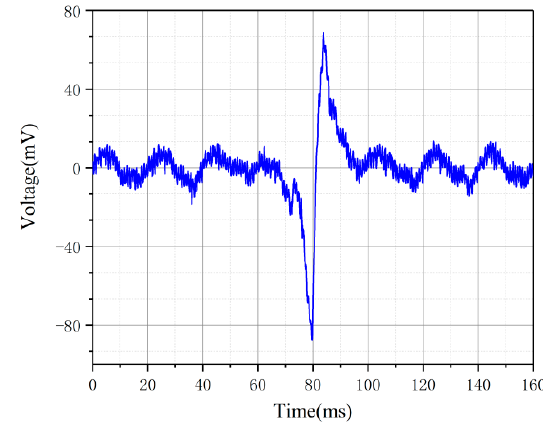
Figure 8. Output wave (0.90 mm length and 0.90 mm diameter iron debris, 2.12 m/s, 0.4 A exciting current).